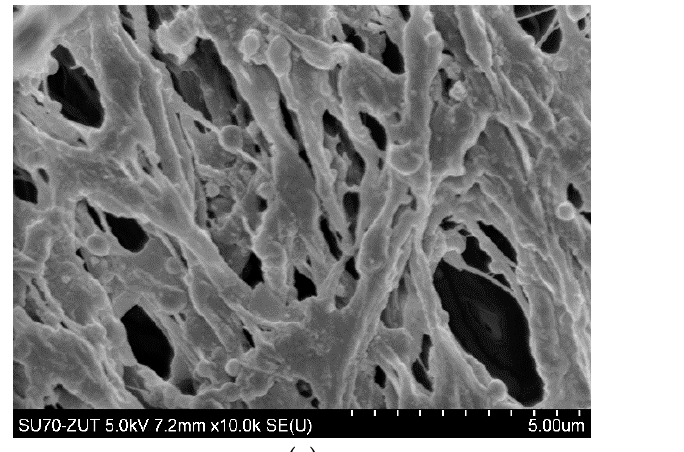
CR—chemical rinsing.